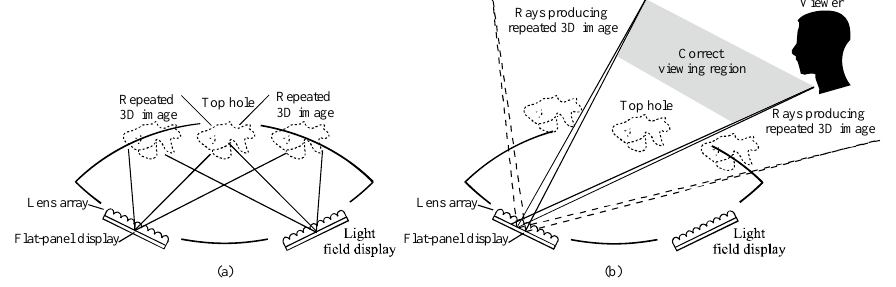
Figure 2. Elimination of repeated 3D images: ( a ) non-tracking technique and ( b ) tracking technique. When the LFD width is denoted by w d , the radius from the central axis of the display system to the center of each screen placed on the circumference is denoted by r , because the angle of view for the LFD width from the center, denoted by ϕ , is given by ϕ = 2 tan − 1 ( w d /2 r ), and the number of LFDs required to assemble the system, denoted by N , is given by: